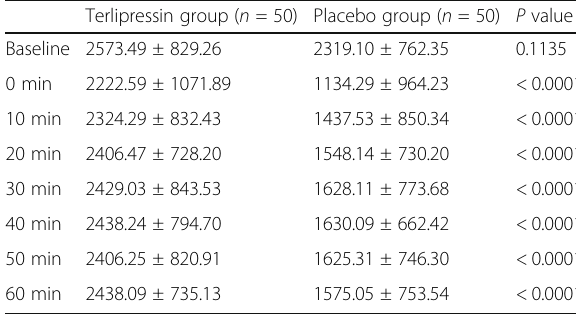
Table 7 Systemic vascular resistance index (dyn.s.cm − 5 ) Terlipressin group ( n = 50) Placebo group ( n = 50) P value Baseline 2573.49 ± 829.26